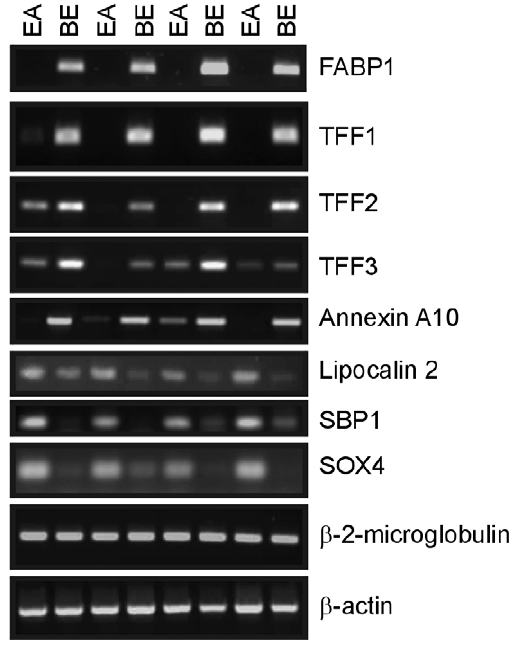
Fig. 2. RT-PCR to validate SAGE results of esophageal adenocar- cinoma and Barrett’s esophagus. RT-PCR on RNA from esophageal adenocarcinoma (EA) and Barrett’s esophagus (BE) biopsies from different patients, demonstrates that Fatty Acid Binding Protein (FABP) 1, Trefoil Factor (TFF) 1, TFF2, TFF3 and Annexin A10 are highly expressed in the Barrett biopsies, but virtually absent in esophageal adenocarcinoma. Furthermore Lipocalin 2, Selenium Binding Protein (SBP) 1 and SRY box (SOX) 4 are highly expressed in esophageal adenocarcinoma biopsies and lower expressed in Bar- rett biopsies. β -actin and β -2-microglobulin were used as a control. Pictures are representative for results of 10 patients.